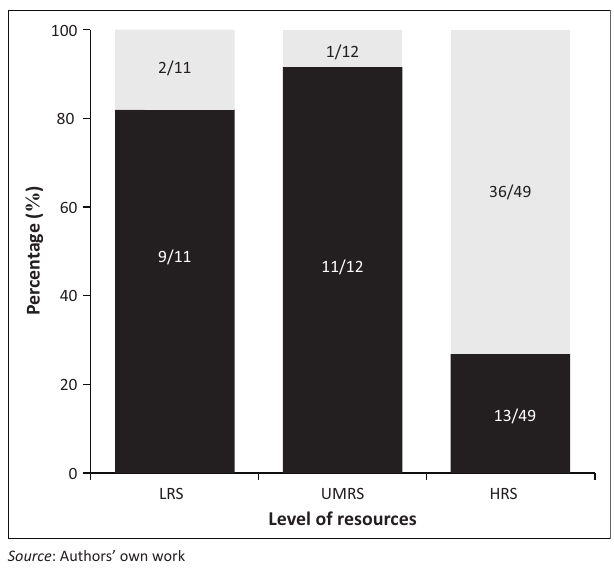
FIGURE 3: Awareness of World Health Organization Wheelchair Service Training Packages in educational institutions based on level of resources.